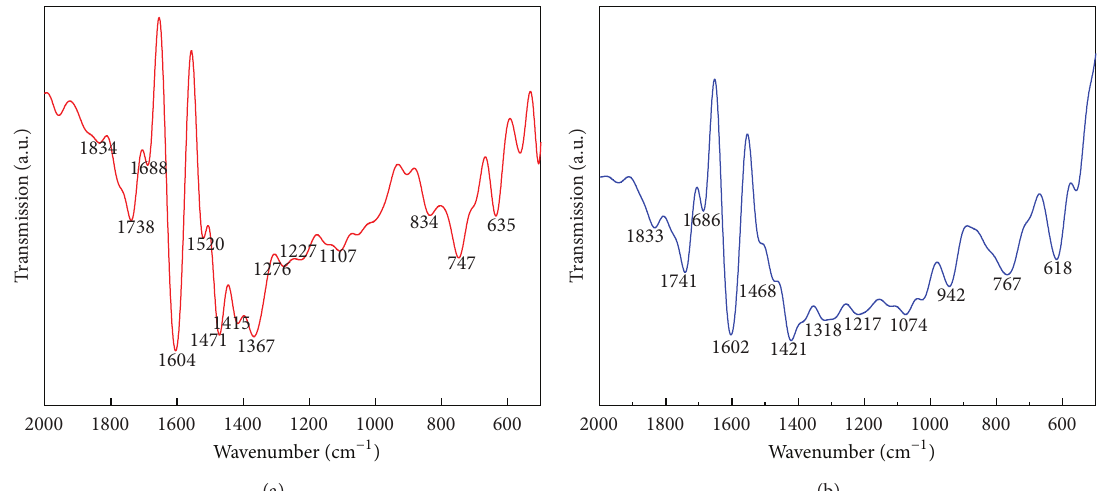
Figure 12: FTIR spectra recorded from SNPs powder synthesized using F. oxysporum by applying optimized conditions (spectra (a): control, (b): experimental).